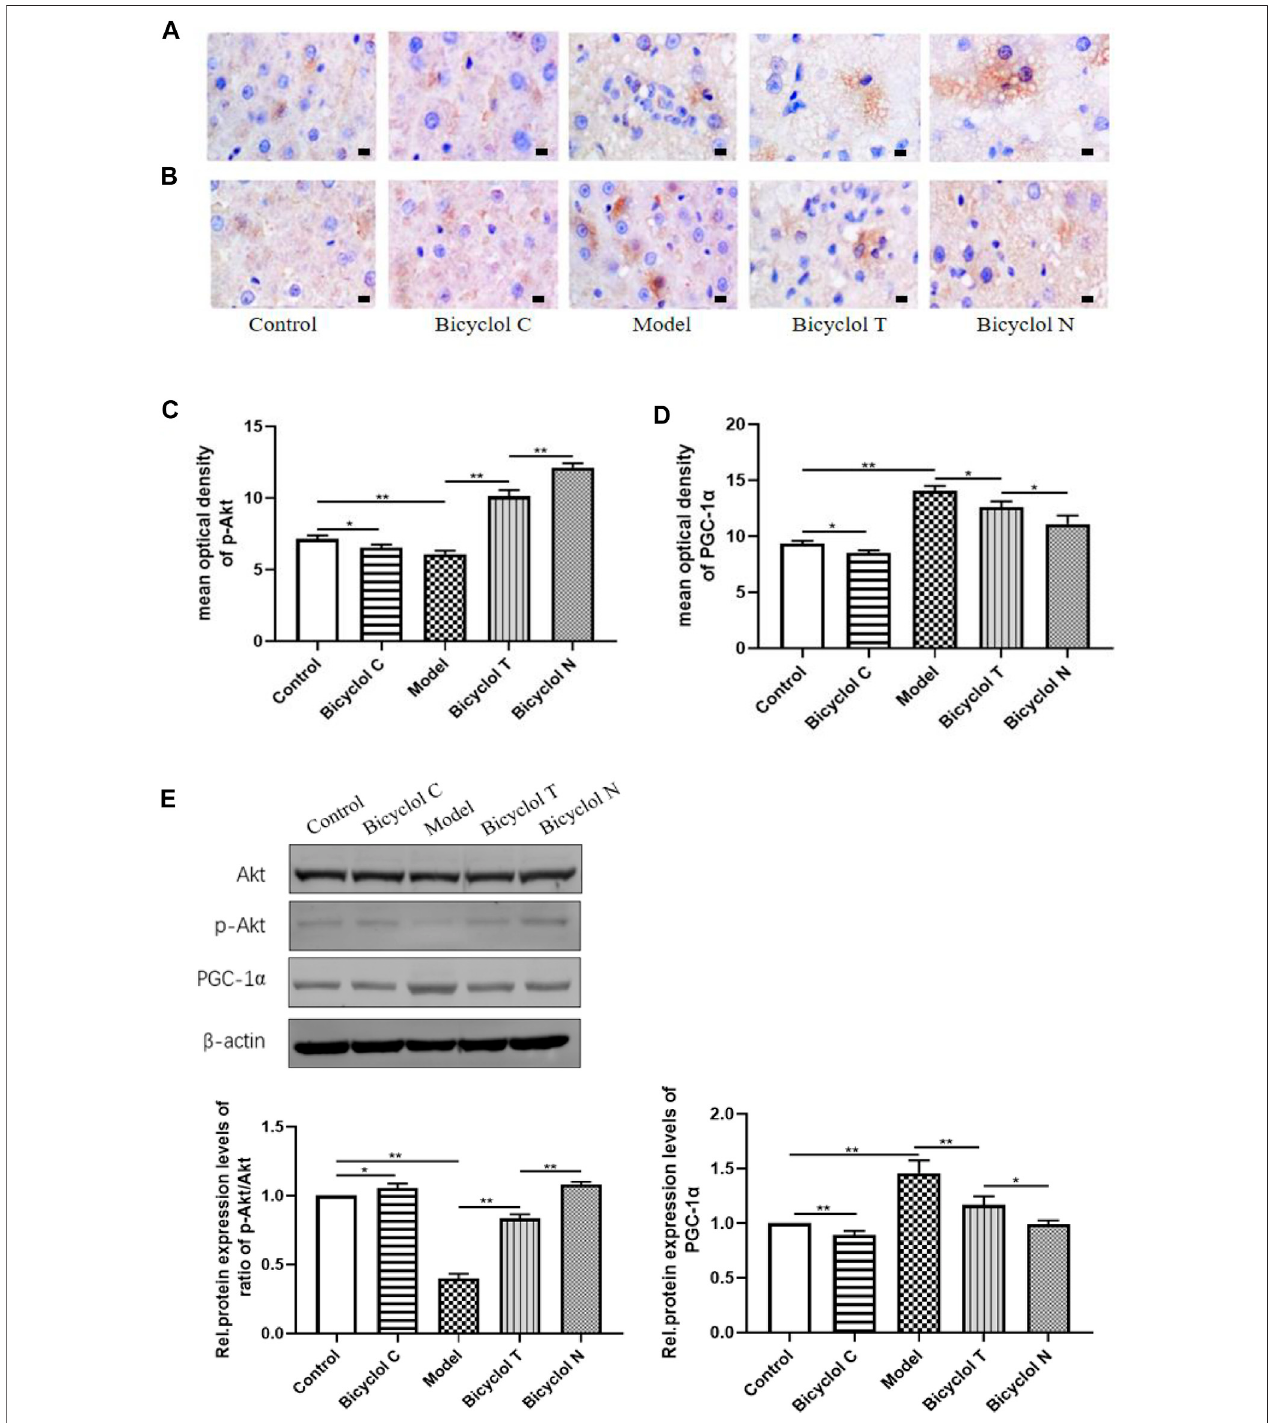
FIGURE 6 | Effect of bicyclol on regulating gene expression of Akt/PGC-1 α signaling pathway in T2DM with NAFLD rat (A) The expression of p -Akt determined by IHC. (B) The expression of PGC-1 α determined by IHC. (C) Mean optical density analysis of p -Akt expressiont in liver. (D) Mean optical density analysis of PGC-1 α expression in liver. (E) Western blot analysis of Akt, p -Akt, PGC-1 α in liver. Data are presented as means ± SD. * p < 0.05. ** p < 0.01.